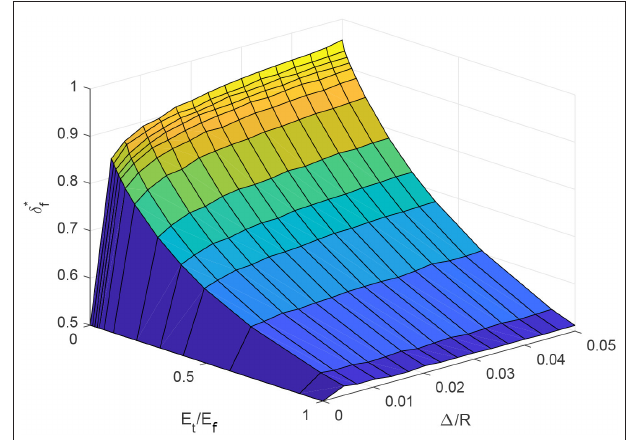
FIGURE 2 | Von-Mises stress distribution for a contact between a purely elastic sphere and a bilinear elastic-plastic flat.